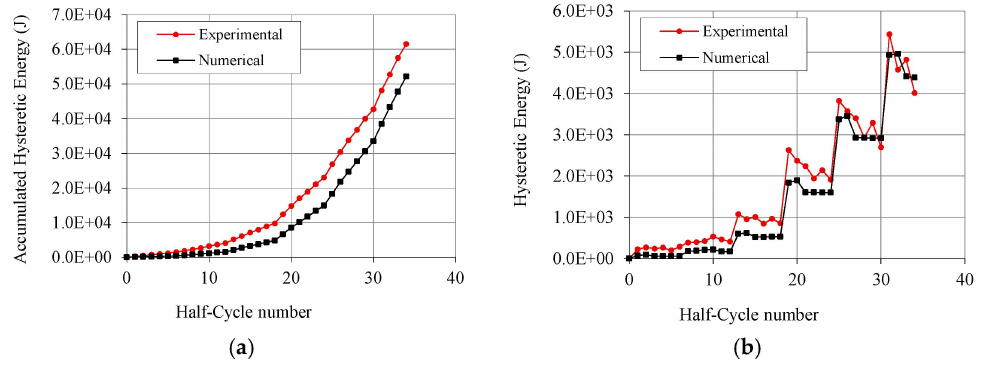
Figure 13. Energy comparison: ( a ) Accumulated hysteresis energy up to the end of the test; and ( b ) Dissipated energy computed for each